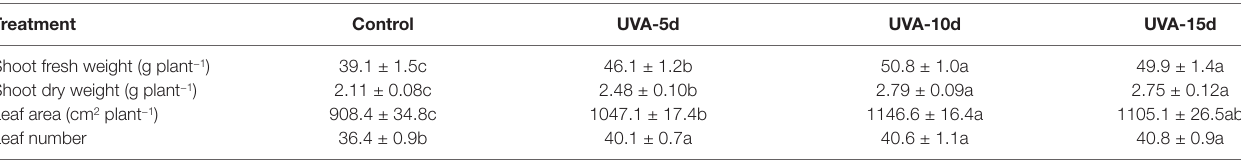
Data represent mean ± SE (n = 8). Means followed by different letters within one row differ significantly (P < 0.05) as established by the least significant difference test.